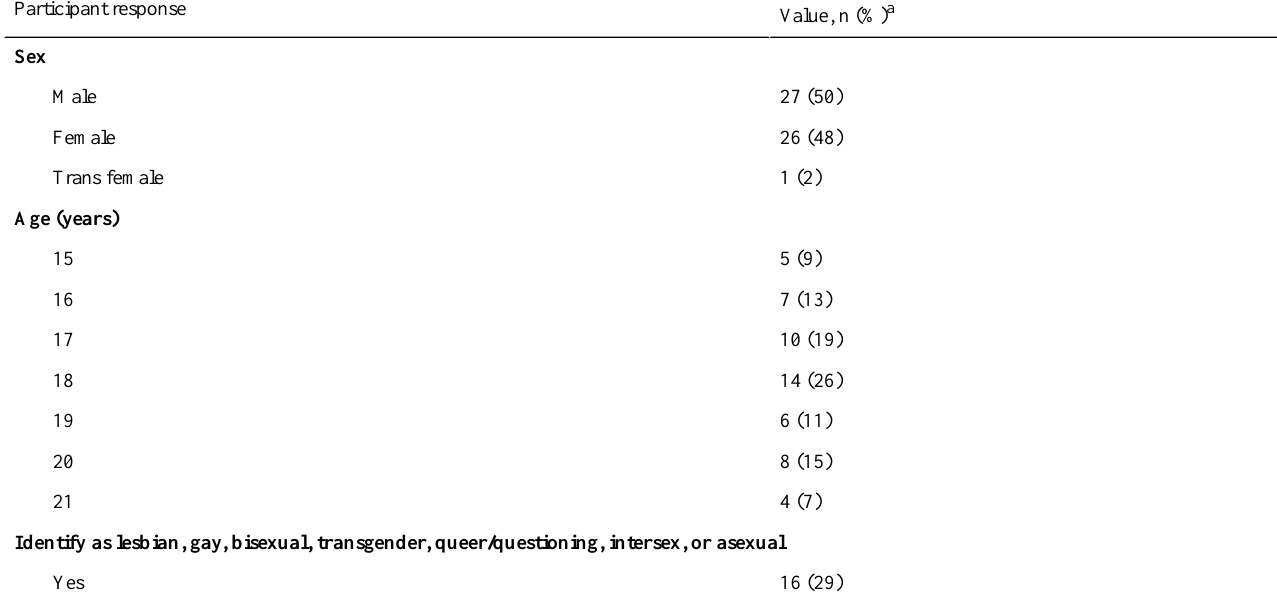
Table 2. Demographics, gaming habits, and sexual history of focus group